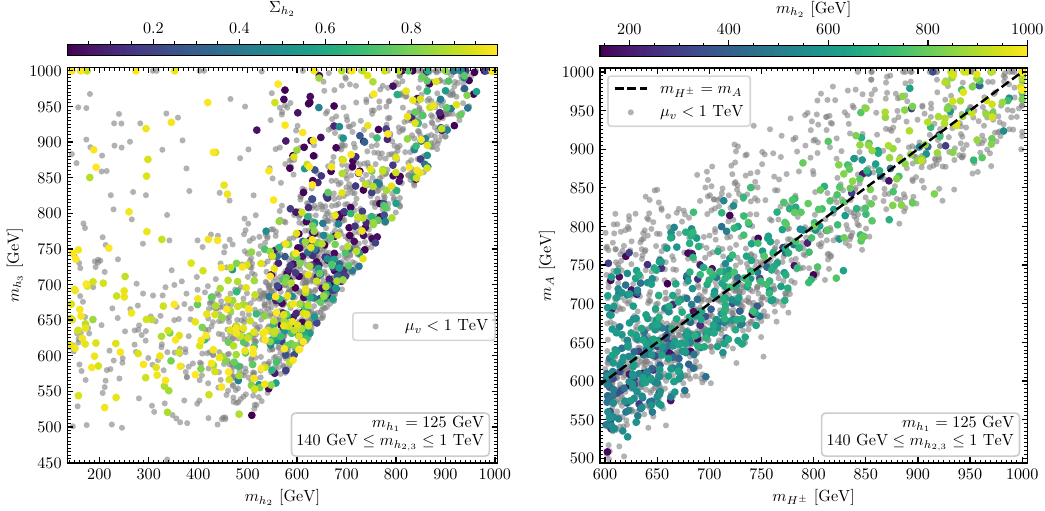
Figure 2 . Spectrum of the heavy Higgs bosons h 2 , 3 , A and H ± for the parameter points fulfilling the theoretical and experimental constraints. Left: m h indicating Σ h . Right: m A in dependence of m 2 grey are excluded parameter points with µ v < 1 TeV . The dashed line indicates where m